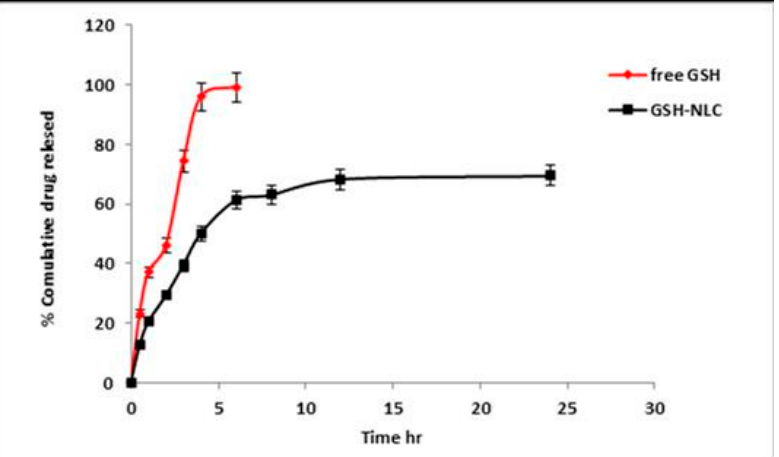
Figure 2. In vitro release profile of the GSH-NLCs formulation compared with free GSH solution in phosphate buffer saline (PBS, pH 7.4 at 37 °C).